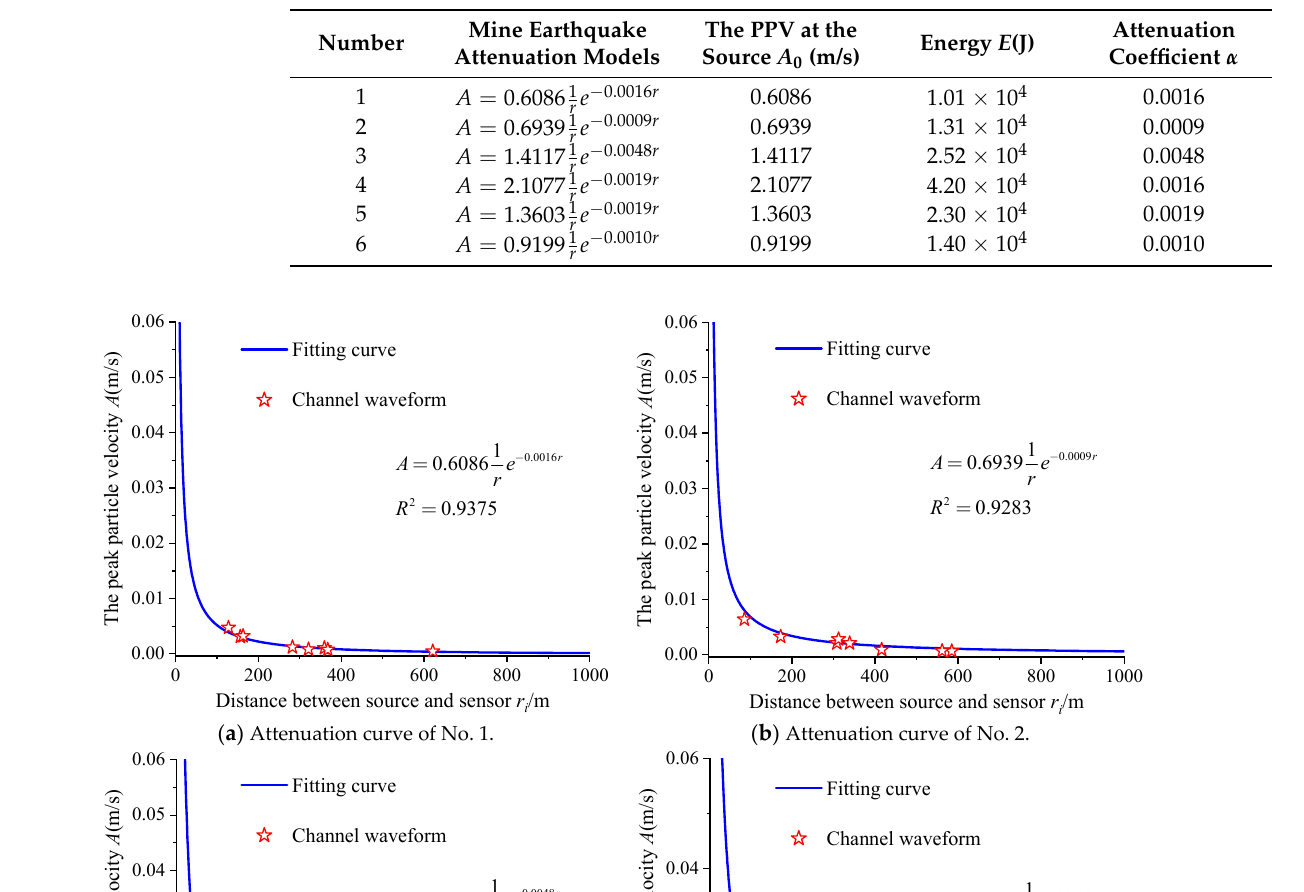
Table 2. Mine earthquake attenuation models.